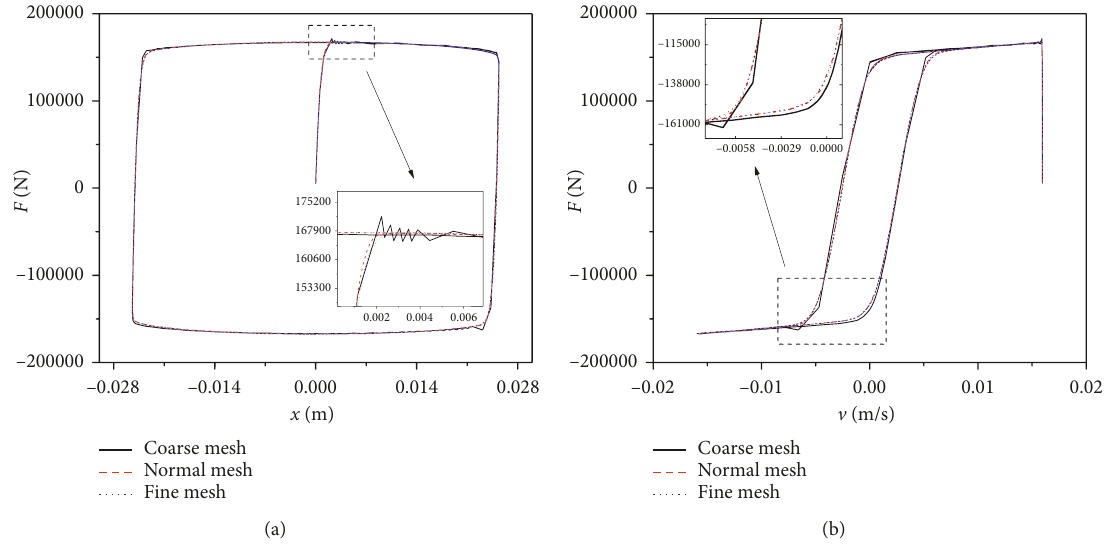
Figure 10: Effect of mesh refinement on FEM